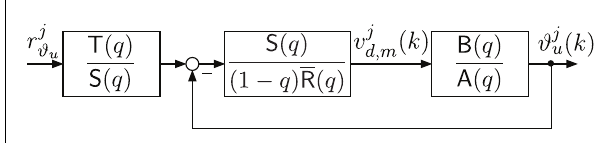
FIGURE 7 | Closed-loop system with discrete-time polynomial